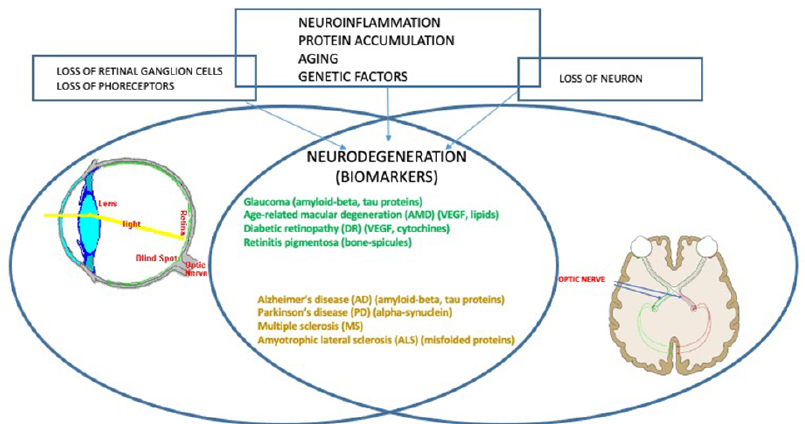
Figure 2. Central nervous system and ocular neuropathologies. The CNS and the eye share the same factors in the etiophatology of disease. Neurodegeneration is common, as are some biomarkers, reported in parentheses for each